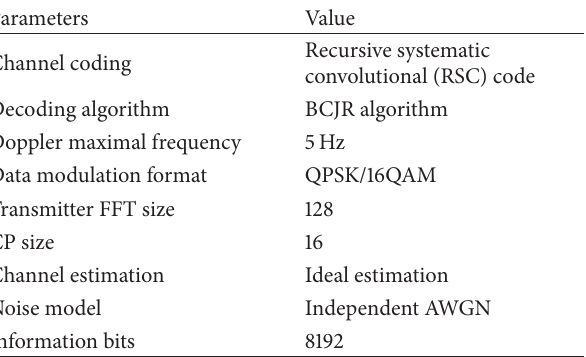
Table 2: Simulation parameters of large-scale MIMO-OFDM sys-